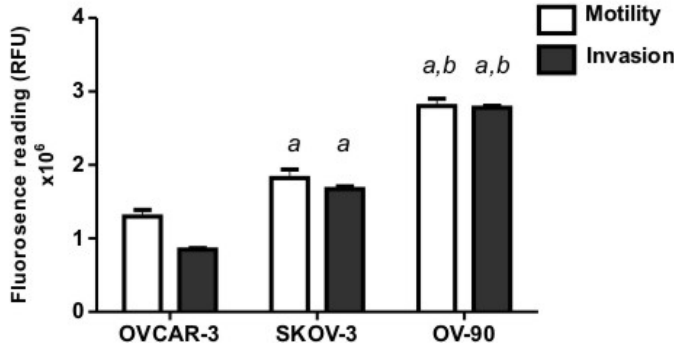
Figure 1. Motility and invasion of human ovarian cancer cell lines (OVCAR-3, SKOV-3 and OV-90) in vitro . The fluorescence reading represents the cancer cells that have migrated through the pores or invaded through the extracellular matrix (Geltrex). Data represents the mean ± SEM from two independent experiments performed in quadruplicate. ( a ) Indicates significant difference from OVCAR-3 cells; and ( b ) indicates significant difference from SKOV-3 cells, p < 0.05.